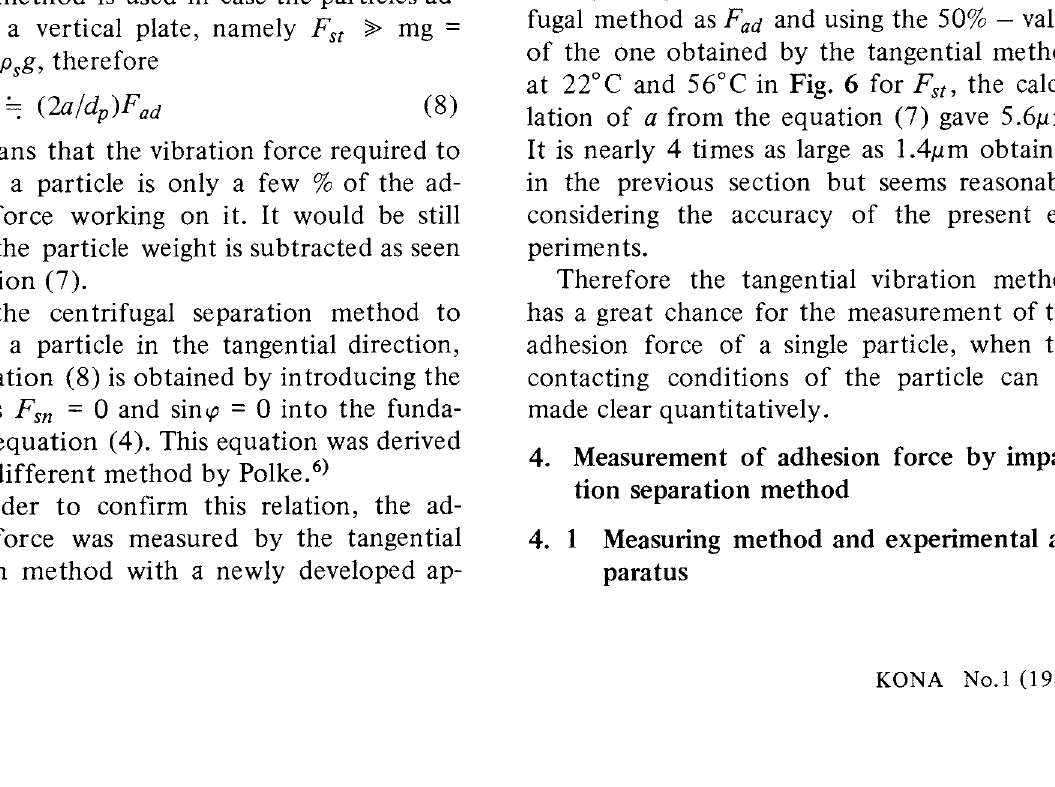
Fig. 6 The results by tangential separation method, with the results by other